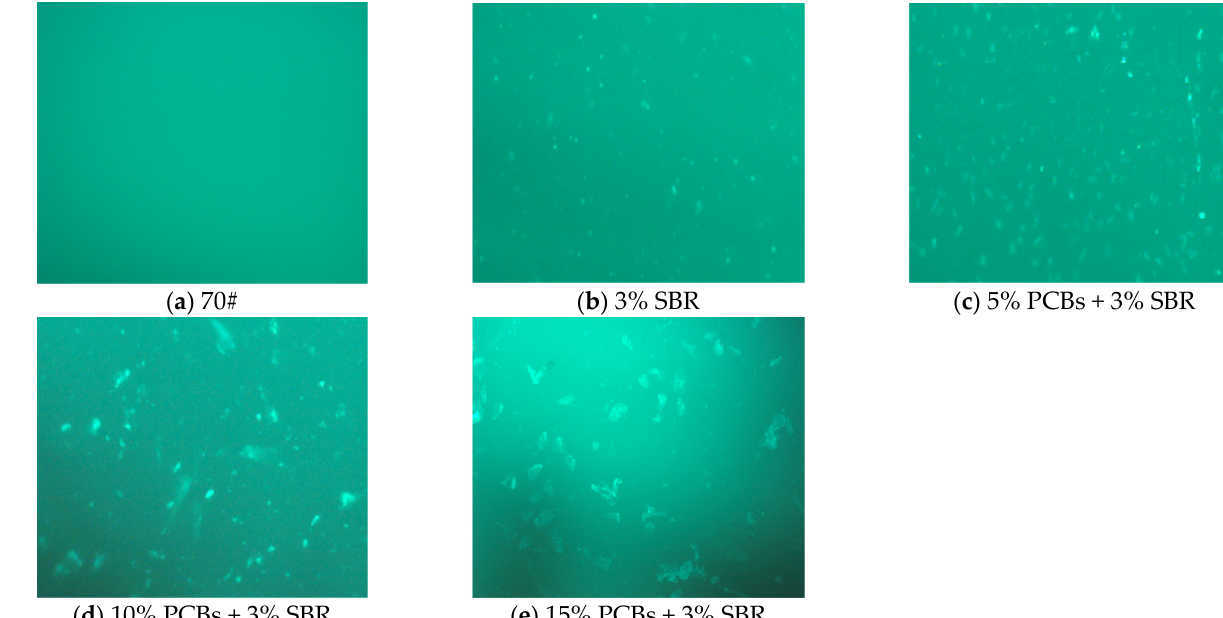
Figure 8. The FM picture of bitumen with different PCBs content. ( a ) 70#; ( b ) 3% SBR; ( c ) 5% PCBs + 3%SBR; ( d ) 10% PCBs + 3% SBR; ( e ) 15% PCBs + 3% SBR (all observed at 50 magnification).